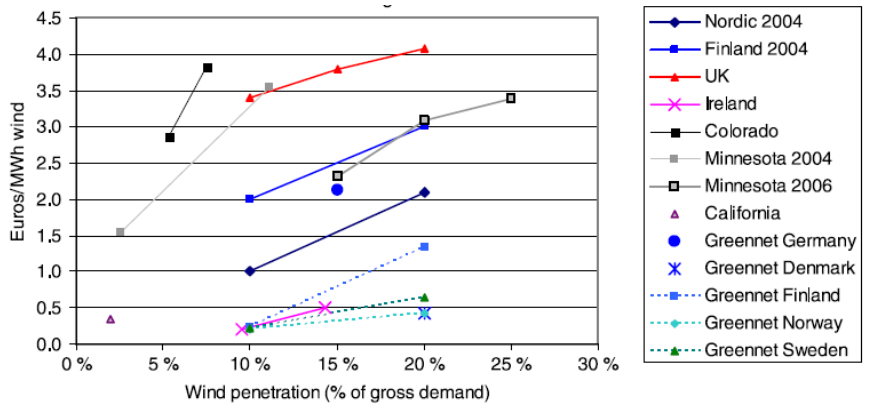
Figure 53. Increase in balancing requirements per kWh of wind power as a function of wind penetration (© 2008 IOP, reproduced with permission from [204]).